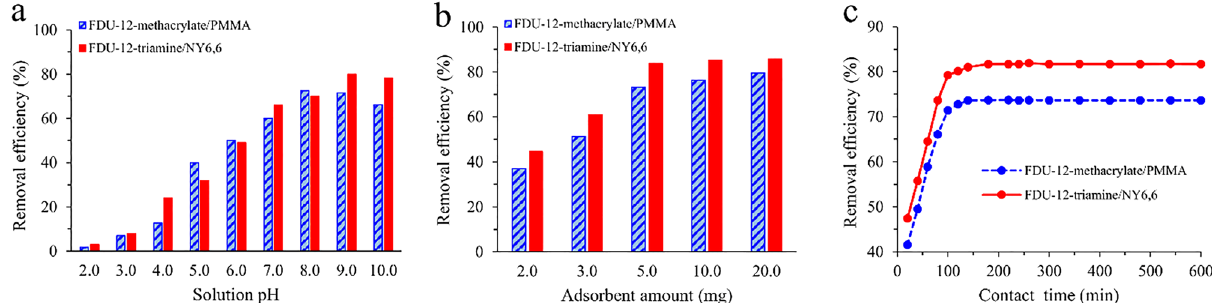
Figure 6. The effect of (a) pH, (b) adsorbent amount, and (c) contact time on the adsorption